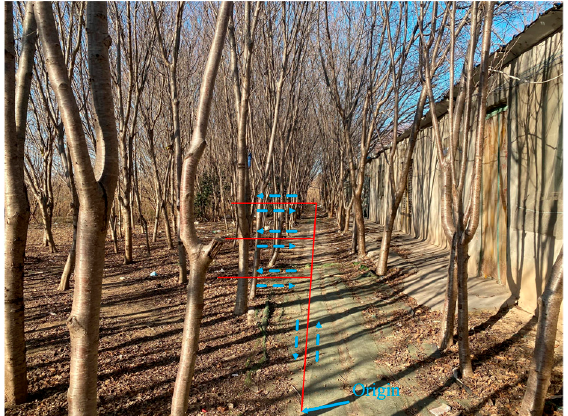
Table 3. Localization MSEs of soldiers using di ff erent algorithms in a forest environment experi- ment.